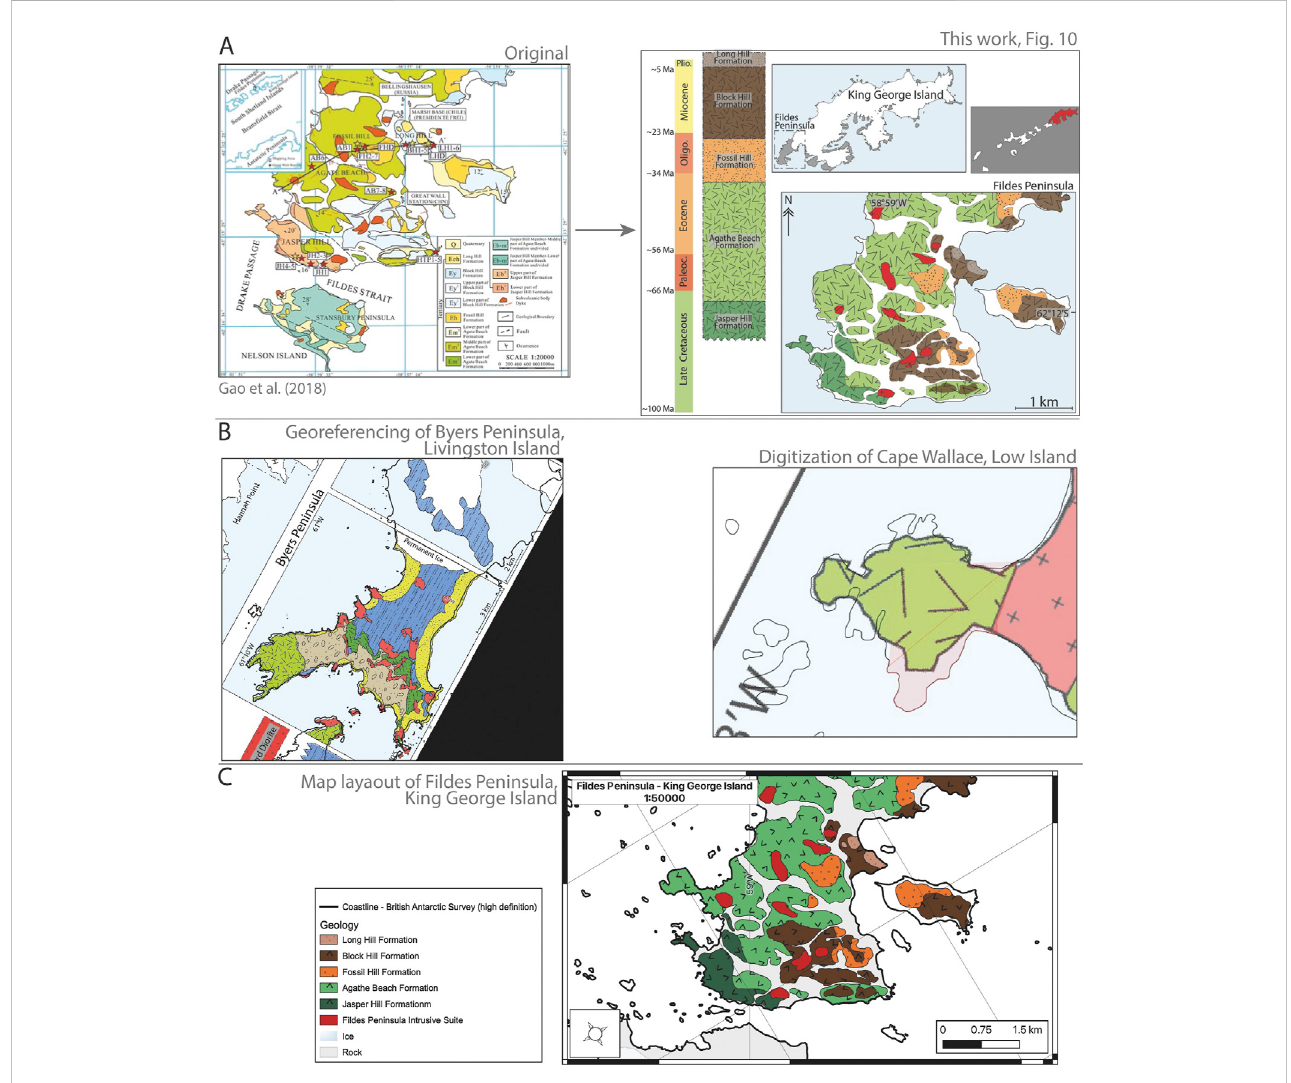
FIGURE 2 Work fl ow employed in this study. (A) A geological map from the literature (Gao et al., 2018). (B) The geological maps were georeferenced by using the coastline high-de fi nition shape fi le from Gerrish et al. (2021) and digitization in QGIS v3.24 of the units to create a polygon shape fi le of the